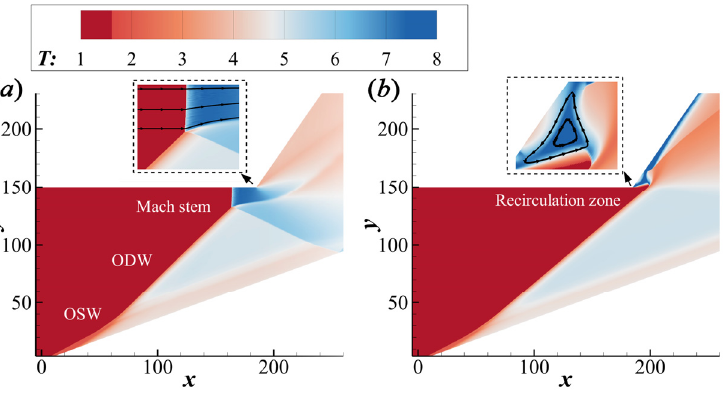
Figure 2. Temperature fields for ODWs in the case of ( a ) M 0 = 5.5; ( b ) M 0 = 6.0. Black curves represent streamlines.